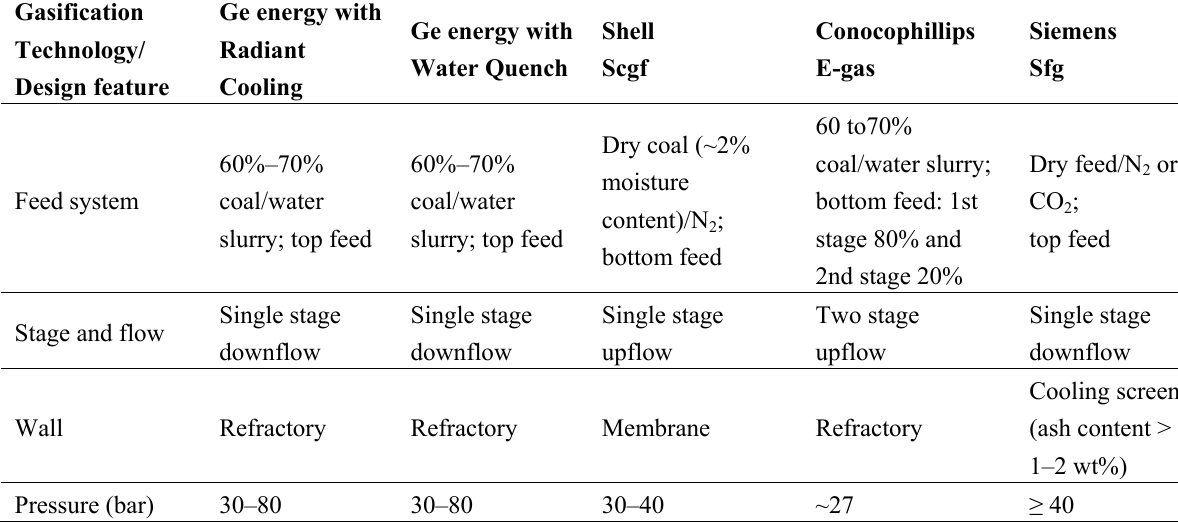
Table 1. Characteristics of major commercial entrained-flow technologies